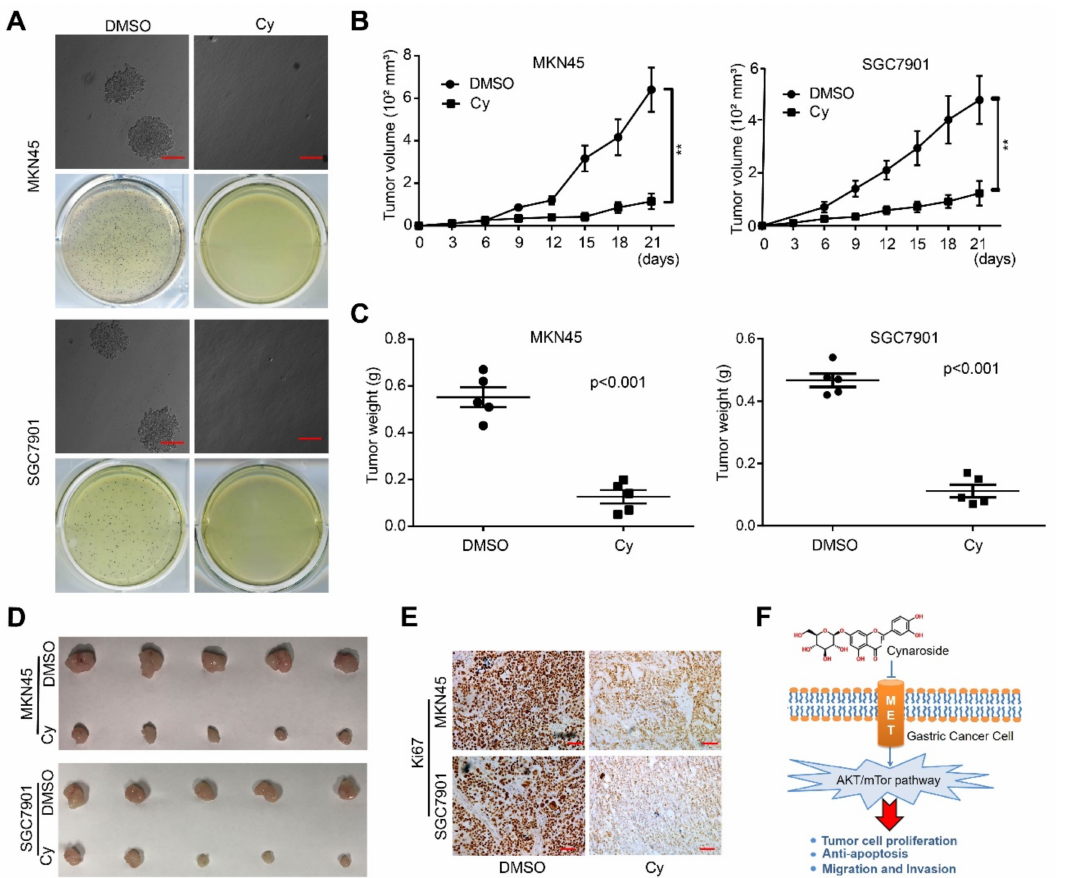
Figure 6. Cynaroside inhibits the tumorigenesis ability of gastric cancer cells in vivo and in vitro. ( A ) The gastric cancer cells were treated with 50 µ M Cy, and the soft agar test was used for detection; DMSO was used as a control. ( B ) The volume of the tumor removed from the mice. ( C ) The weight of the tumor removed from the mice. ( D ) Image of mouse xenograft tumor. ( E ) The immunohistochemistry experiment was used to detect the expression level of Ki-67 in mouse tumor tissues. ( F ) Model for effects of Cy in gastric cancer. ** p < 0.01, p -values < 0.05 were considered as statistically